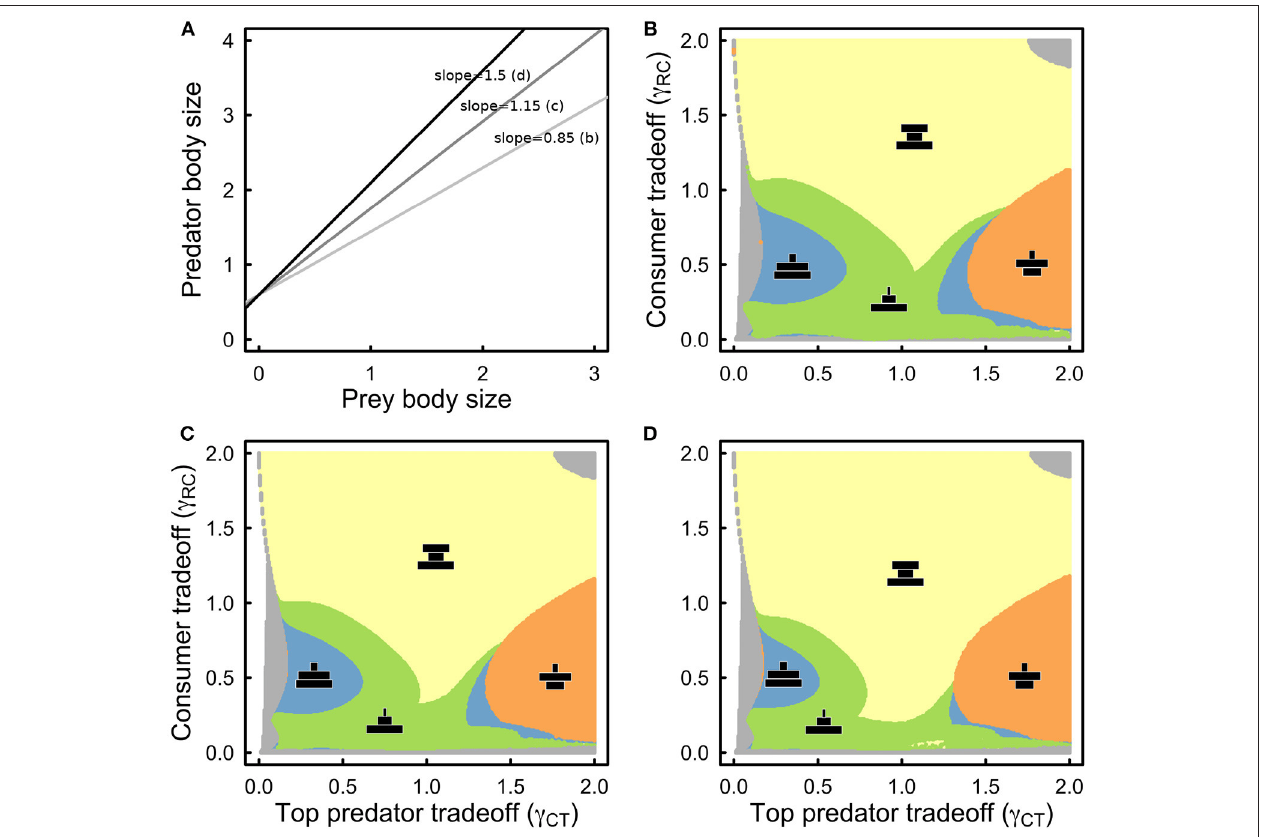
FIGURE 4 | (A) Plot of the assumed predator-prey body-size scalings where only the scaling exponent was allowed to change. The middle line is the average taken across taxa (Brose et al., 2006). (B) Same as in Figure 3A , but with respect to biomass structure and assuming 0.85 as the slope of the predator-prey body size scaling. (C) As in (B) but for a slope of 1.15. (D) As in (B,C) but for a slope of 1.5. Color coding and qualitative biomass depictions (black) as in Figure 3 . All other parameter values as in Table 1